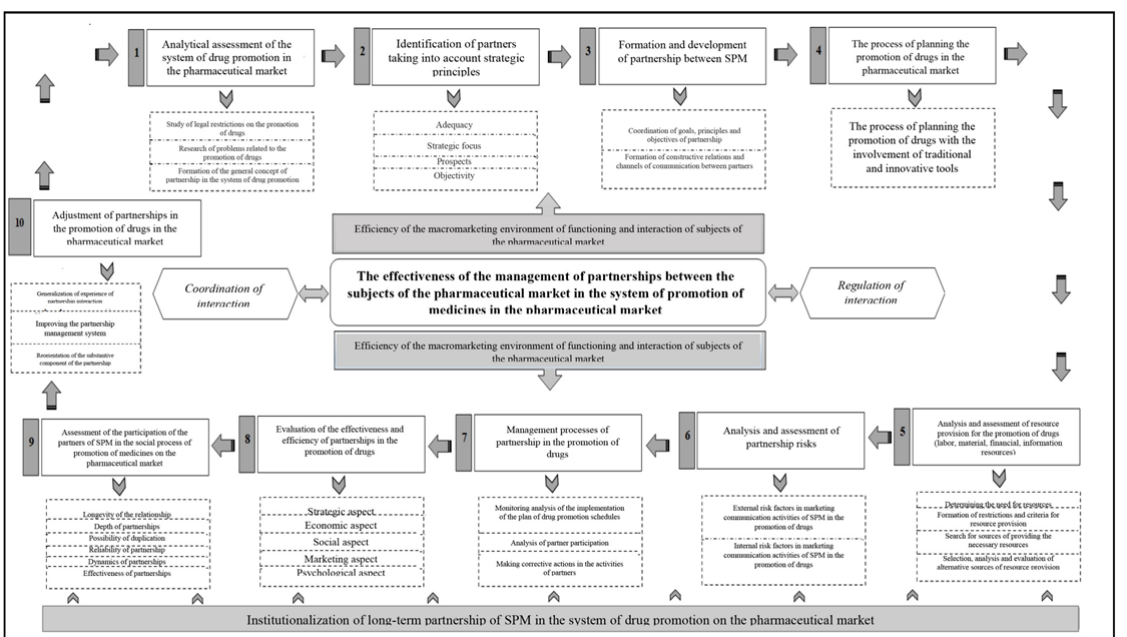
Fig. 1. Conceptual model of formation of strategic partnerships and efficiency of their management between